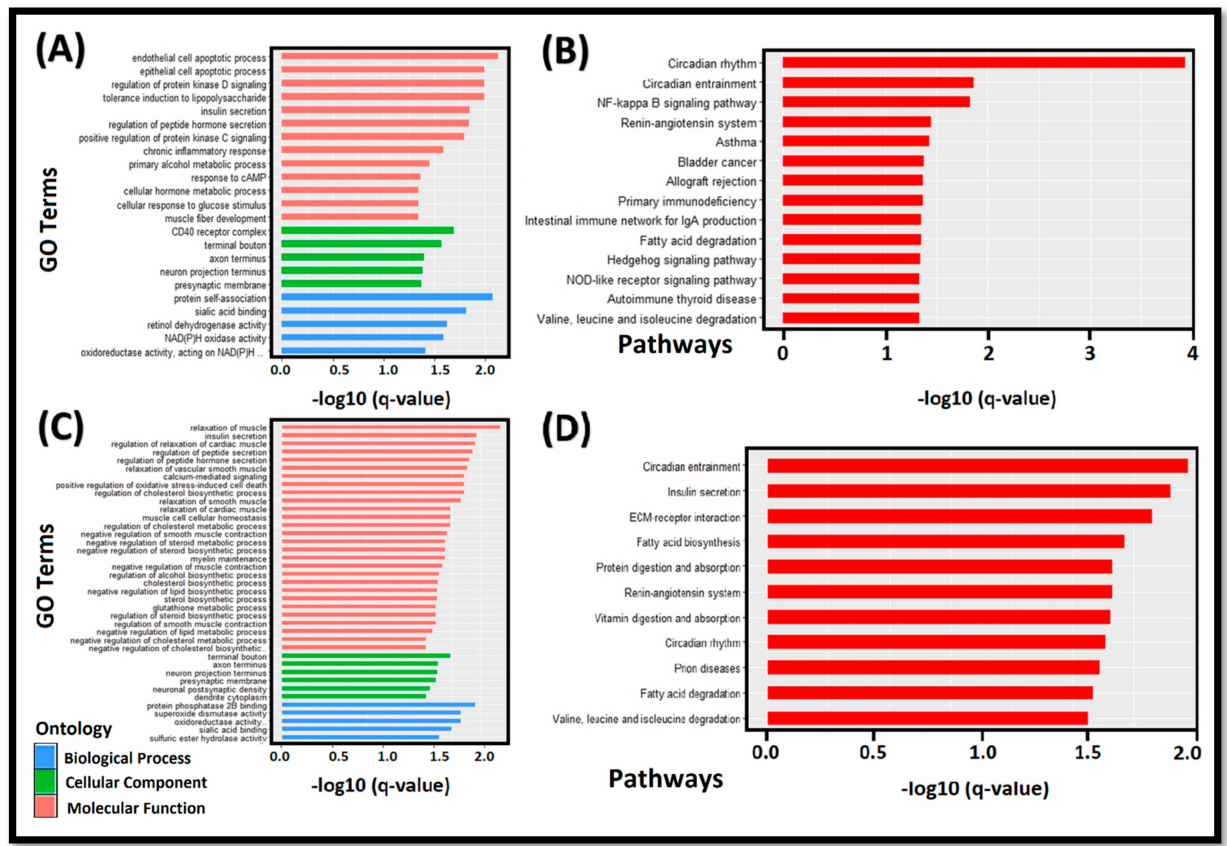
Figure 6. Functional enrichment analysis of the target genes; ( A , B ) represent the GO and KEGG pathway enrichment analyses of the target genes of circRNA_08840, respectively; ( C , D ) display the GO and KEGG enrichment results for circRNA_23437-associated target genes,